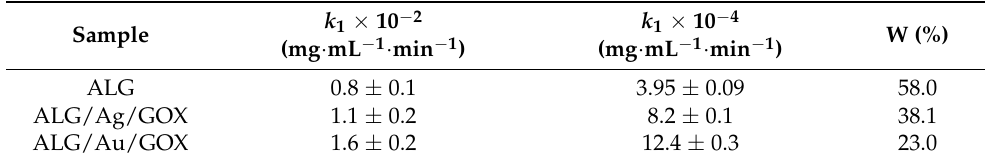
Table 3. Values of rate constants (k) and hydrolysis yields (W).